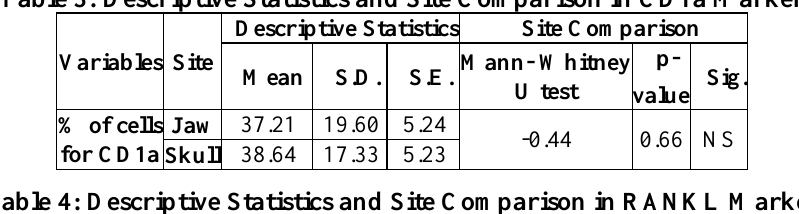
Table 3: Descriptive Statistics and Site Comparison in CD1a Marker